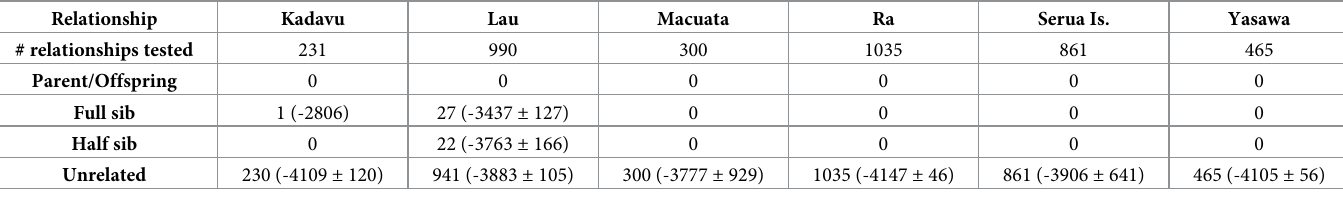
Table 3. Summary of individual pairwise relationships assessed using MLRelate for each sample group. The number and mean ± SD of the natural log likelihood of each type of relationship (in brackets) are presented.